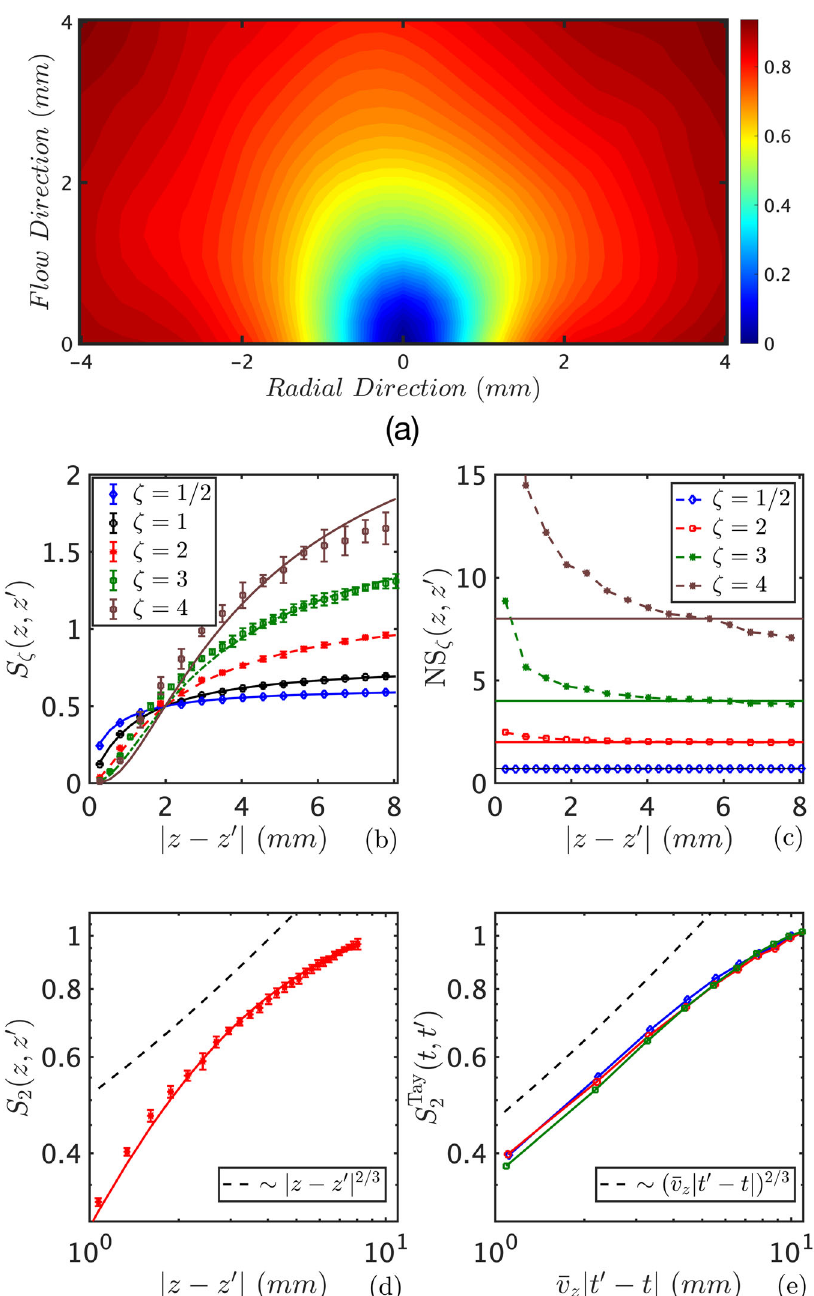
Fig. 4 Properties of structure functions. a Contour plot for S 1 R ; R 0 ð Þ shows that it is nearly isotropic when d ¼ j R 0 (cid:4) R j is small, but that the growth slows in the fl ow direction as d increases. Panels b – e show mean values (symbols) and standard deviations (error bars) for variables computed using 6000- ; R 0 ð Þ (blue diamonds), S ; R 0 ð Þ (black circles), S ; R 0 ð Þ (red frame segments with four distinct origins R on the symmetry axis. b The symbols show S 1 = 2 R 1 R 2 R crosses), S 3 R ; R 0 ð Þ (green squares), and S 4 R ; R 0 ð Þ (brown stars) in the fl ow direction. The black line is the best fi t of the data S 1 ( z ) for a functional form S ð z Þ ¼ c z c 3 = ð 1 þ c z c 3 Þ that satis fi es the conditions for j R (cid:4) R 0 j ! 0 and j R (cid:4) R 0 j ! 1 . c Normalized structure functions N S ð z Þ for ζ = 1/2, 2, 3, and 4, ζ 1 1 2 showing the validity of extended self-similarity 17,35 for large j z (cid:4) z 0 j . Extended self-similarity suggests that S ζ ( z ) ≈ 2 ζ − 1 S 1 ( z ) ζ . These are the lines shown in -law holds. e An assessment of the structure function from a single-point time series b . d S 2 ð z ; z 0 Þ does not show an inertial range where the Kolmogorov 2 3 invoking Taylor ’ s hypothesis is better approximated by the 2 3 R ; R 0 ð Þ is range, terminating at the Taylor micro-scale, where S 2 = 3 2,3 isotropic and scales like j R 0 (cid:2) R j 2 , and that higher-order ζ = 3 . Experimental structure functions scale as S ζ R ; R 0 ð Þ (cid:6) j R 0 (cid:2) R j